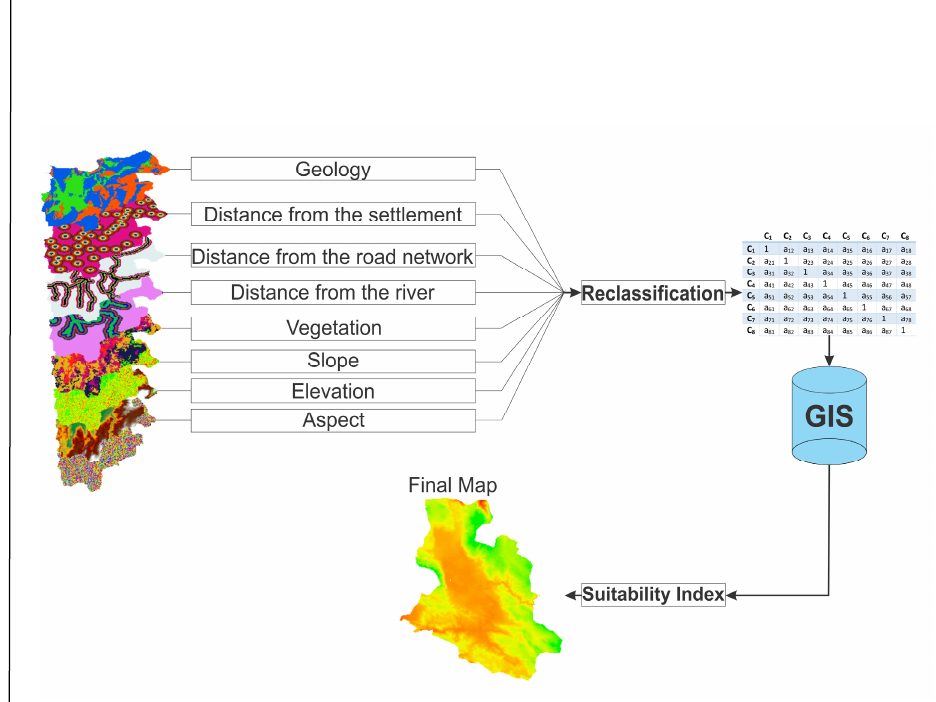
Figure 2 – Scheme of a landfill site selection using GIS and the AHP Рис . 2 – Схема процесса выбора местности для обустройства свалки по ГИС технологии и методам